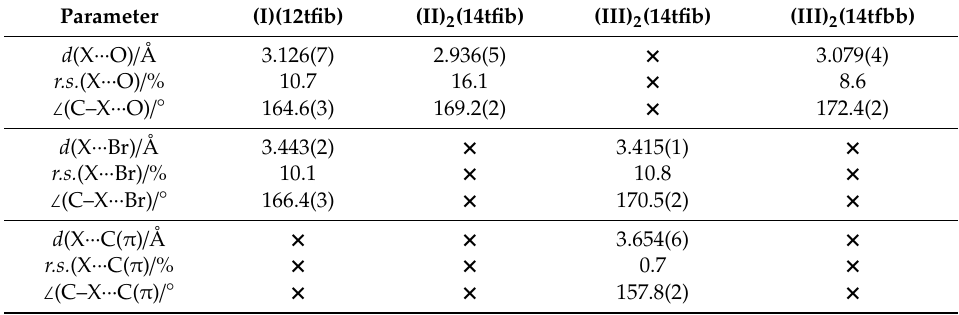
Table 1. Halogen bond lengths, angles and relative shortening in crystal structures of the prepared cocrystals (X = I for 12tfib and 14tfib; X = Br for 14tfbb ). r.s. = 1 − [ d (X ··· Y) / ( r vdW , X + r vdW , Y )].